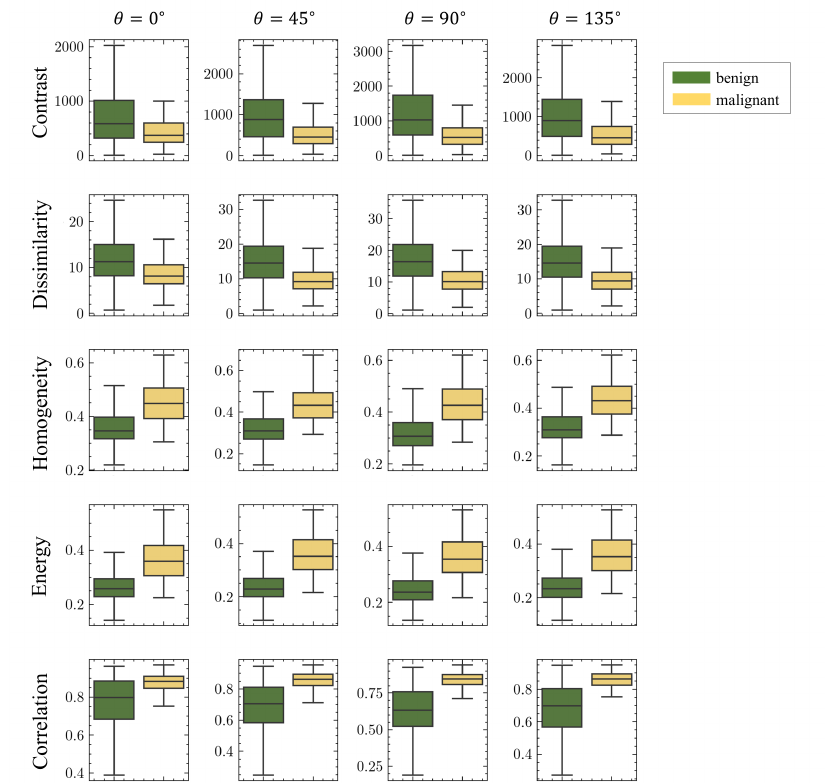
Figure 3. Second-order GLCM texture features. All measure statistics are significantly different between the benign and malignant groups. This significant difference is consistent across various pixel distances ( d = { 1,3,5 } , only d = 3 results are demonstrated here) and angles ( θ = { 0 ◦ ,45 ◦ ,90 ◦ ,135 ◦ } ). Refer to Tables A2–A7 for the deception of each metric and detailed t -test